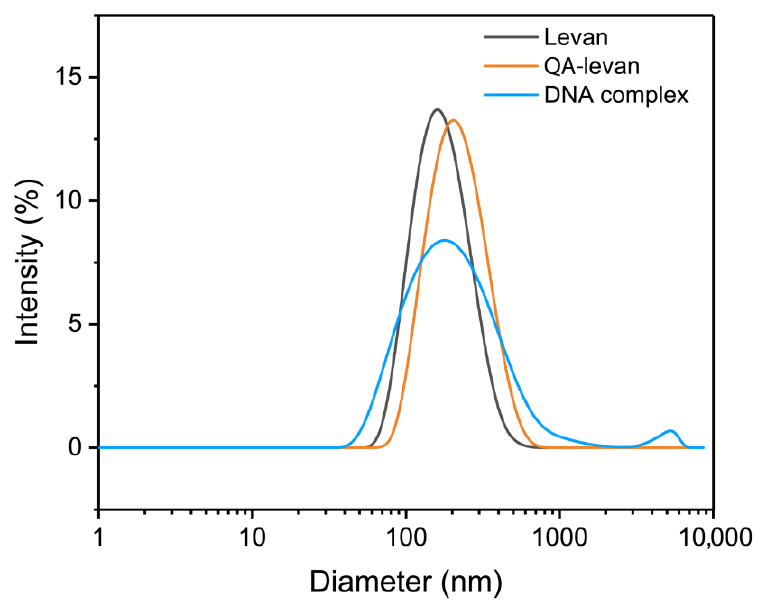
Figure 3. Gel Electrophoresis image of the levan and QA − levan (0.1 – 0.4 μ g) synthesized by different